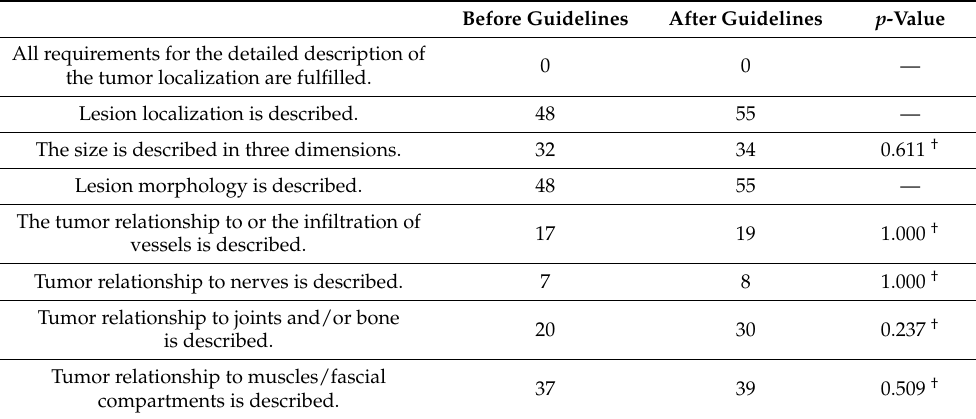
Table 4. Report content criteria before and after guideline